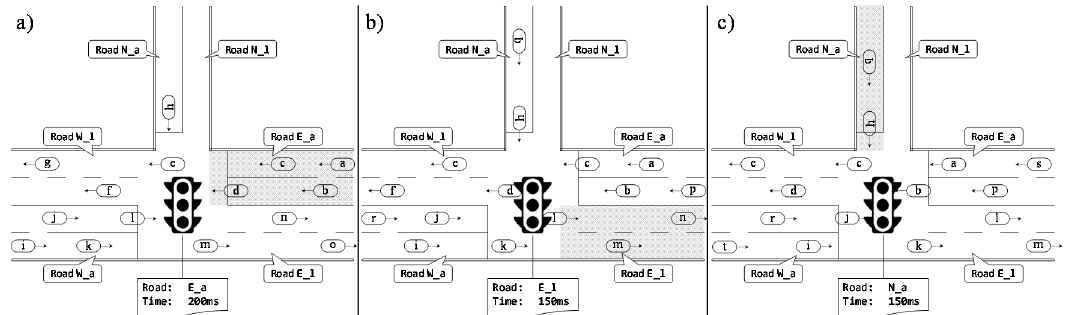
Figure 1. TraSLowPeR sample operation on a three way intersection. In ( a ) the RSU sends a request message limited to the road east arriving (E_a), with a reply windows of 200 ms. The nodes a, b, c, and d will then reply to the message. After the reply window elapses, the RSU will send a new request message, ( b ), for the road east leaving (E l). Next the RSU will probe the road north arriving, ( c ). The TraSLowPeR RSU will continue to sample all the roads converging in its intersection in a round robin fashion.